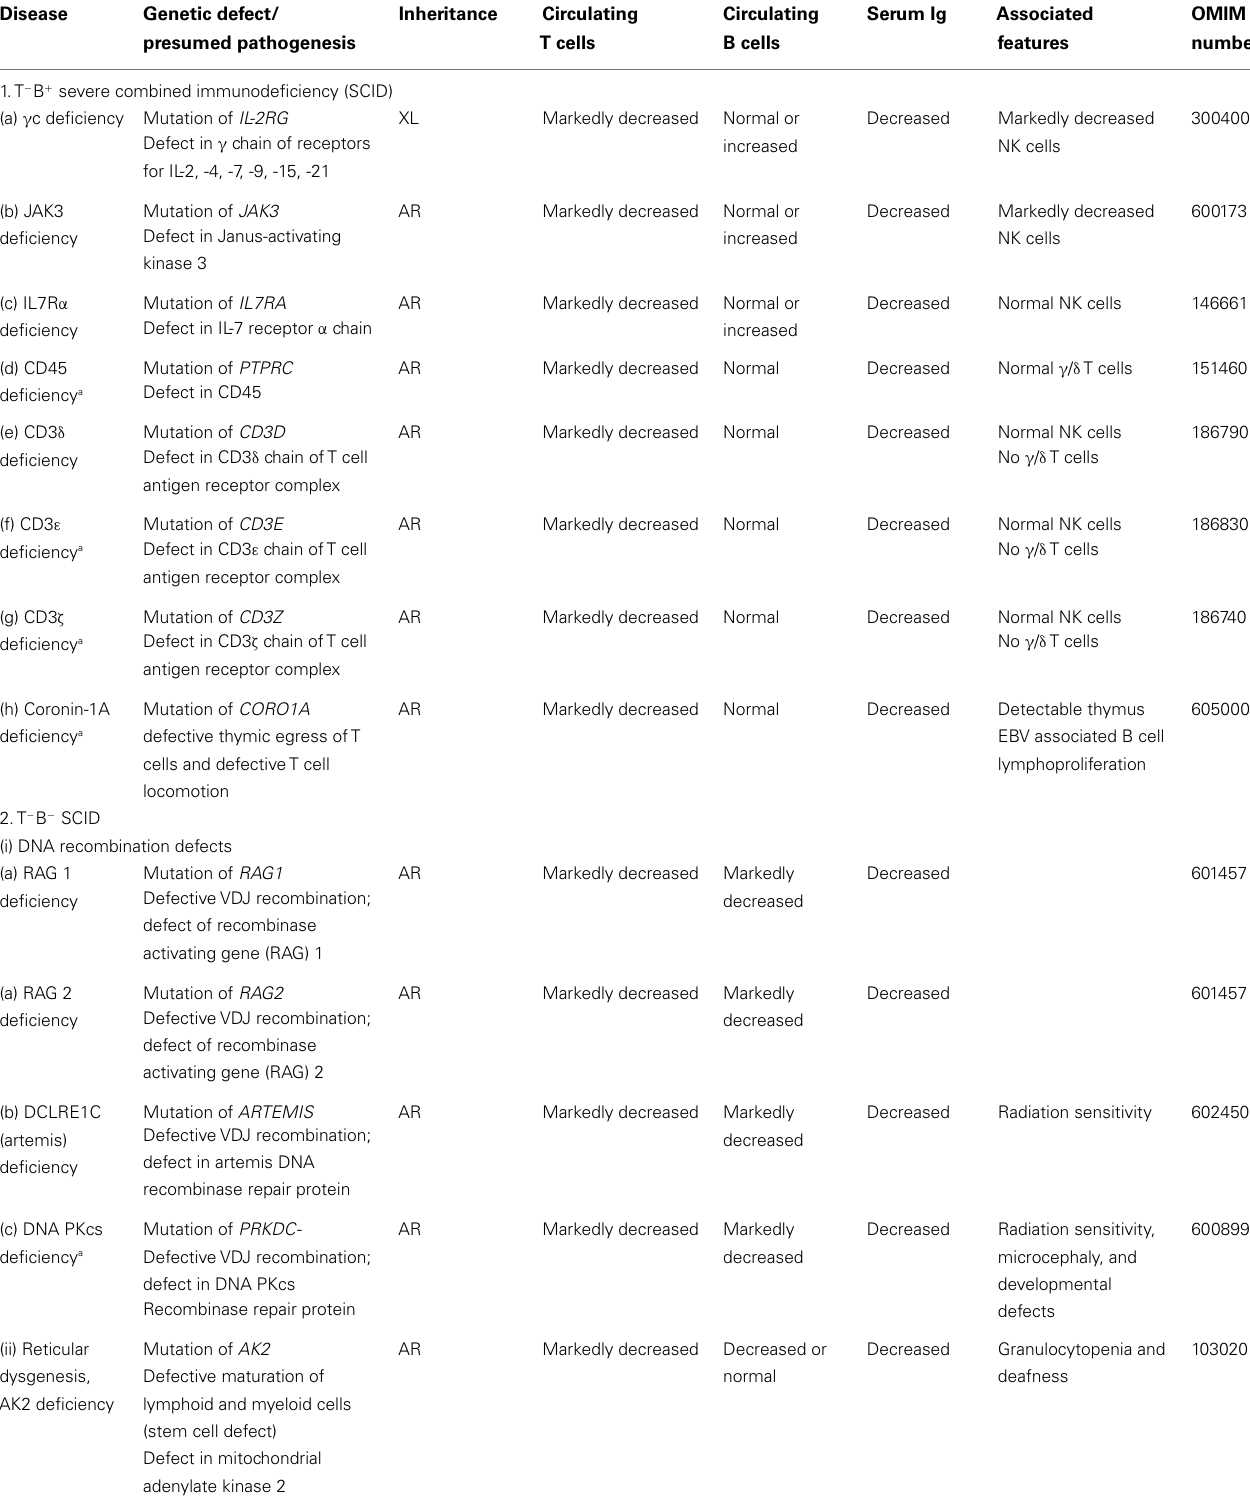
Table 1 | Combined